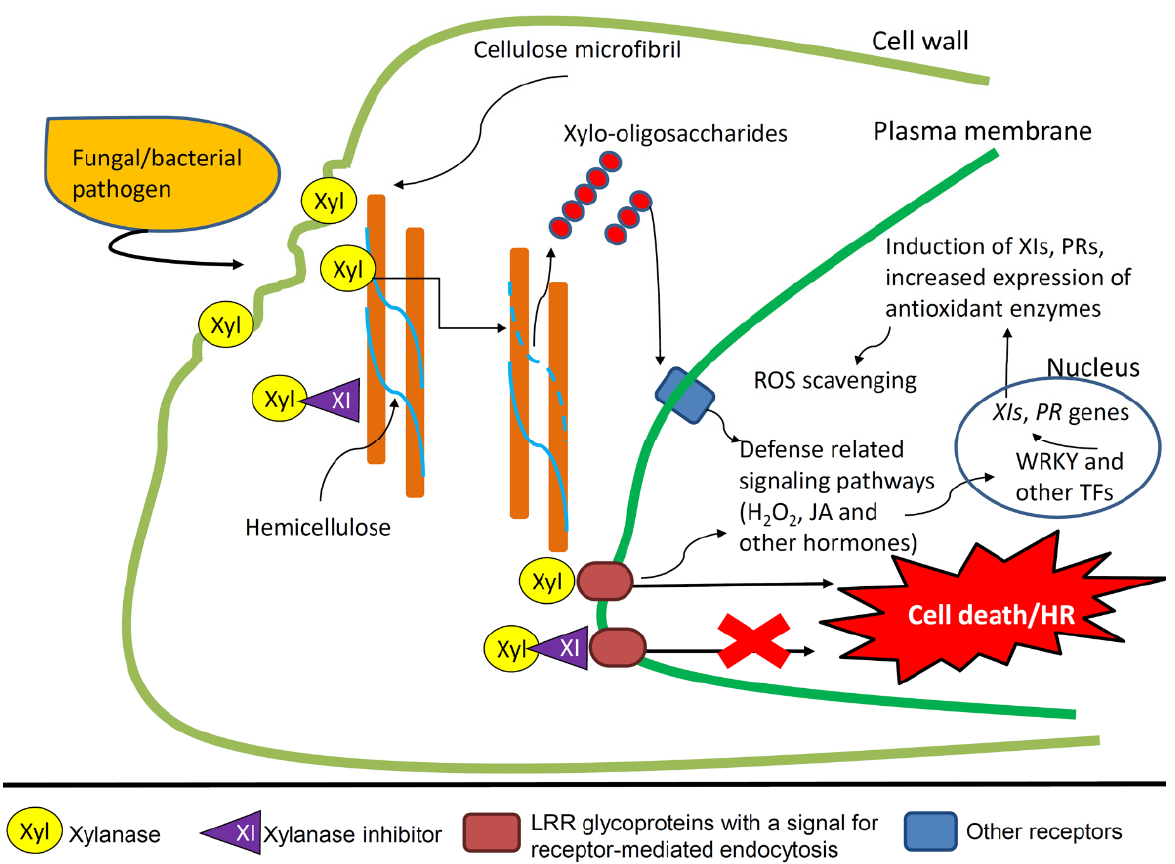
Figure 5. Schematic representation of the inhibitory activity of XIs towards bacterial or fungal xylanases and defense responses activated by the xylanase-xylanase inhibitor interaction. The enzymatic inhibition by XIs prevents hemicellulose degradation and cell wall disassembly. The release of xilo-oligosaccharides (XOS) by the activity of xylanases likely induces plant defense responses through their recognition by plant receptors. Additionally, XIs prevent necrosis of plant cells likely triggered by the binding of xylanases with a putative receptor. Currently, a receptor has been identified only in tomato as an LRR-like glycoprotein [91]. The interaction of XIs with xylanases amplifies defense-related pathways, such as H 2 O 2 release and JA-mediated signaling, which lead to increased expression of XIs, PRs, and antioxidant enzymes, as demonstrated in rice overexpressing RIXI [22]. The antioxidant enzymes catalase and superoxide dismutase have a role as ROS scavenging to decrease oxidative stress.